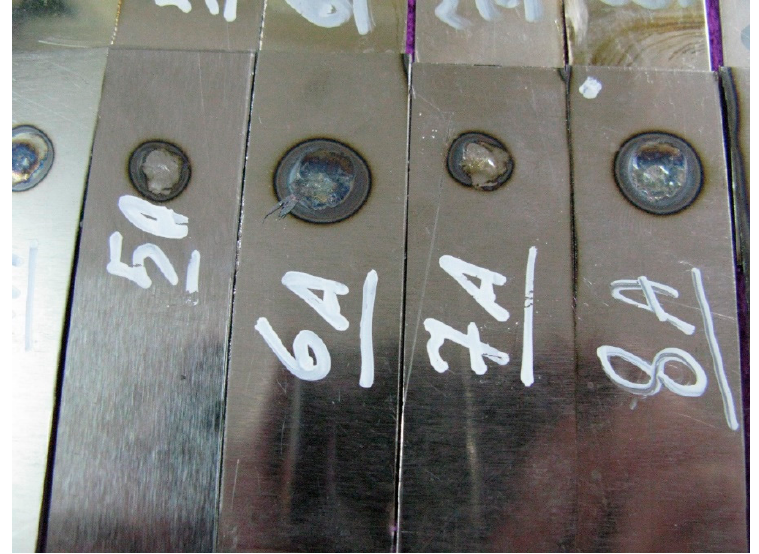
Figure 3. Some of the welded specimens by RSW according to Table 3 experiments.